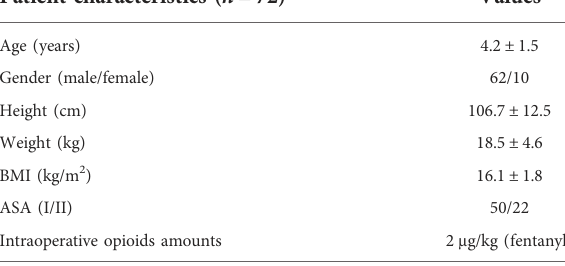
TABLE 1 Patient clinical